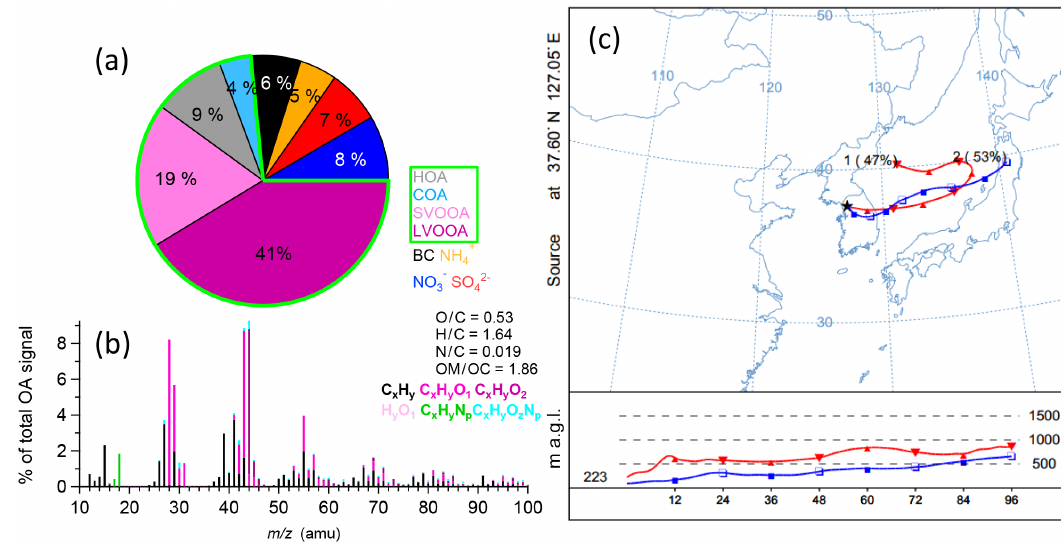
Figure 10. (a) Average compositional pie chart of PM 1 species (non-refractory PM 1 plus black carbon (BC)) and each of the OA factors over an organic-dominant period (20 May, 17:00–24 May, 00:00). The green outline indicates the fraction of total OA; and (b) the average high-resolution mass spectrum of OA colored by the different ion families. The average elemental ratios for the OA fraction are described (a) ; (c) two clusters of back-trajectories of air masses arriving at KIST during the organic-dominant period (20 May, 17:00–24 May,